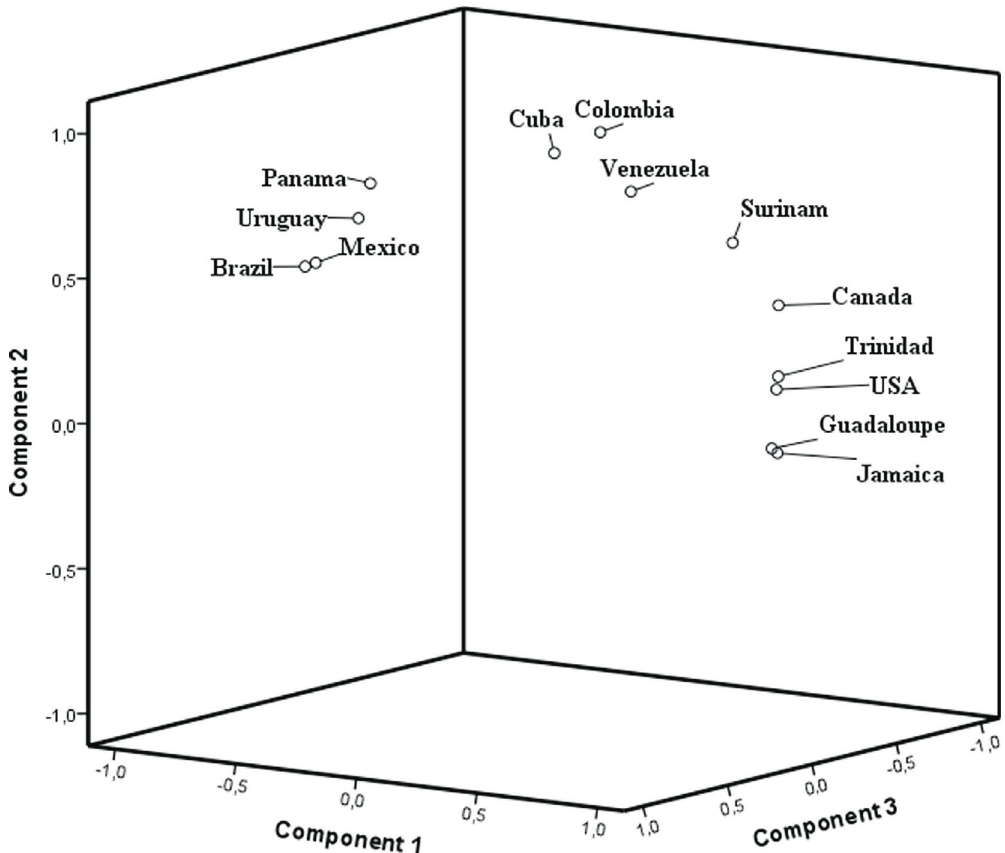
Figure 2 - PCA based on F ST distances calculated using haplotype frequencies showing clustering patterns for different American populations according to HBB*S